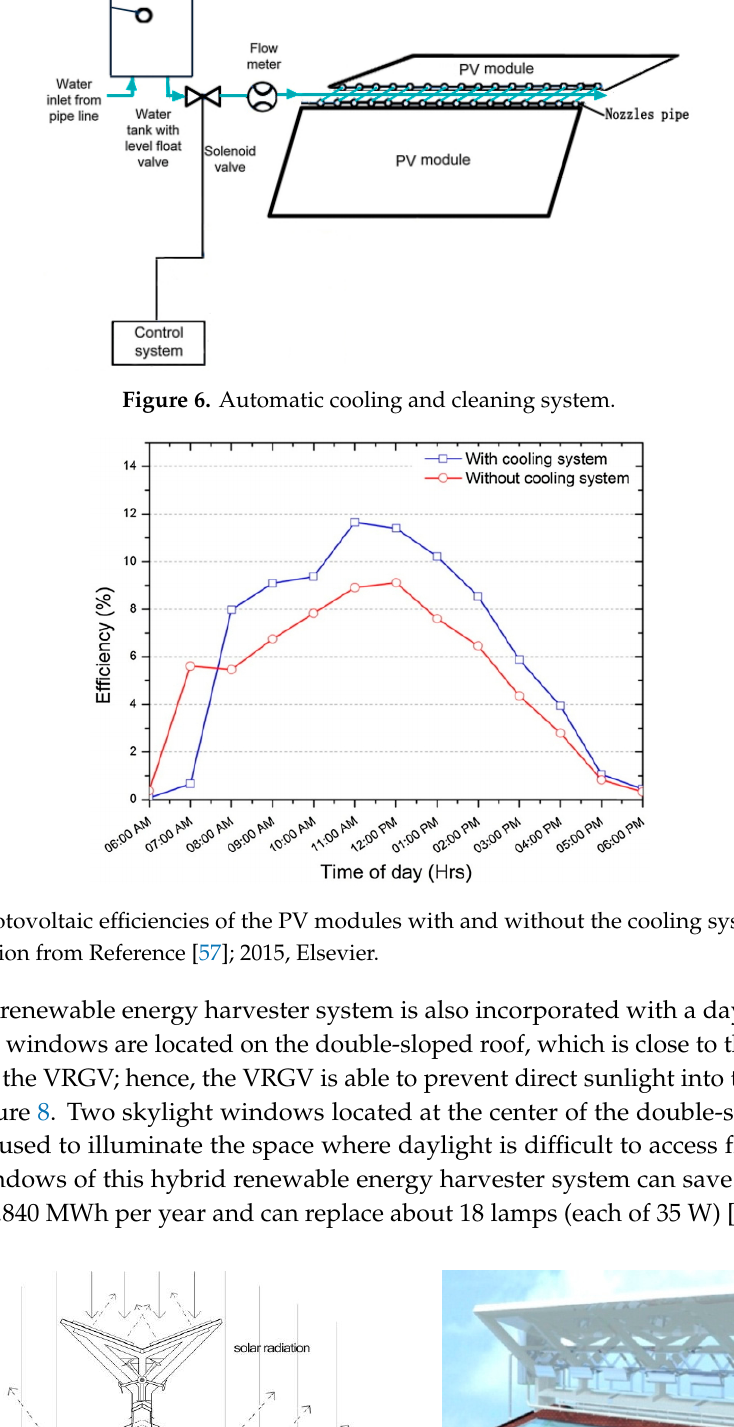
Figure 8. Daylight harvesting system diagrams: ( a ) Schematic diagram; ( b ) skylight windows.